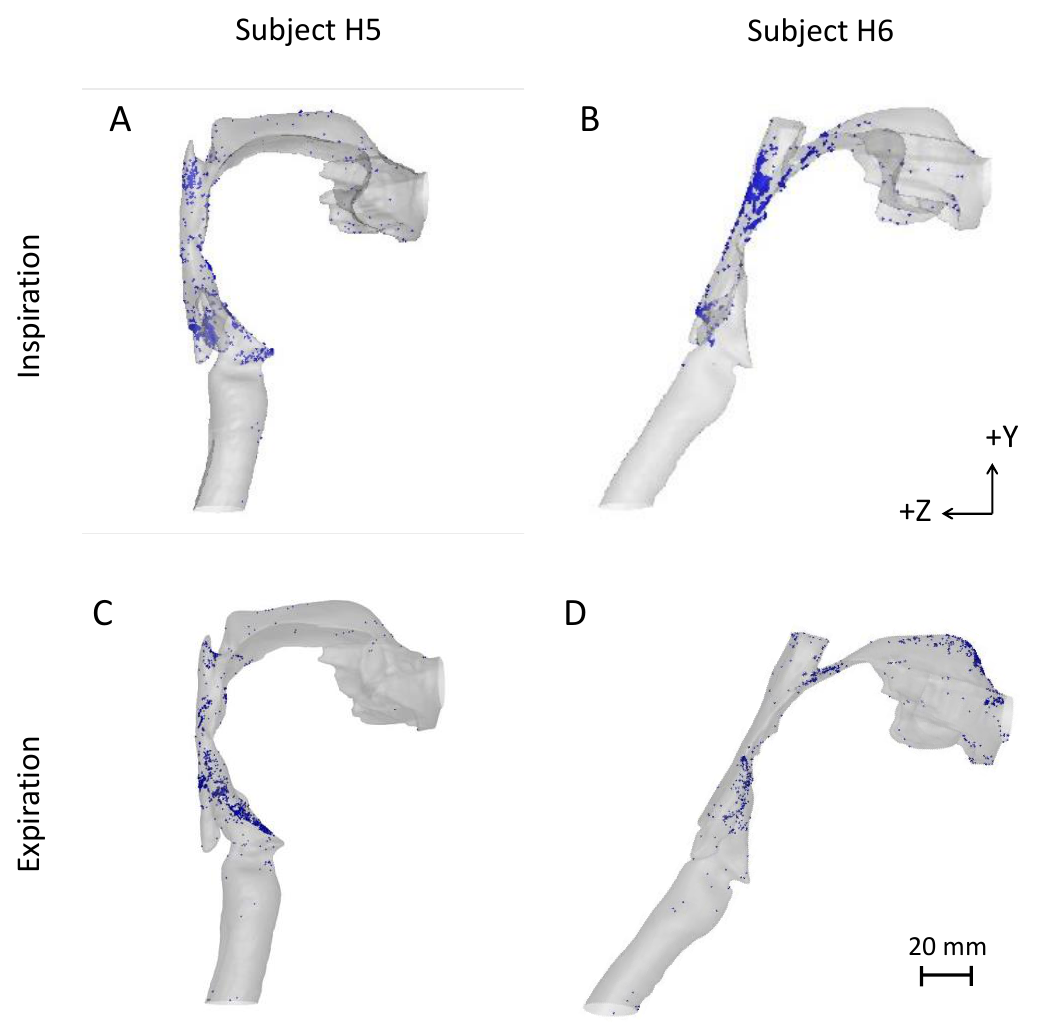
Figure 4. Spatial distribution of deposited 3 µ m particles in two subjects with largely different upper airway anatomy. Data are shown for an inspiratory ( A , B ) and expiratory ( C , D ) flow rate of 45 L/min in subject H5 ( A , C ) and H6 ( B , D ).